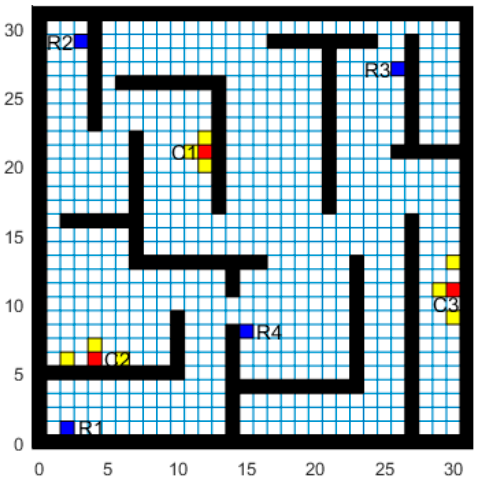
Figure 3. Grating diagram of the underwater environment.